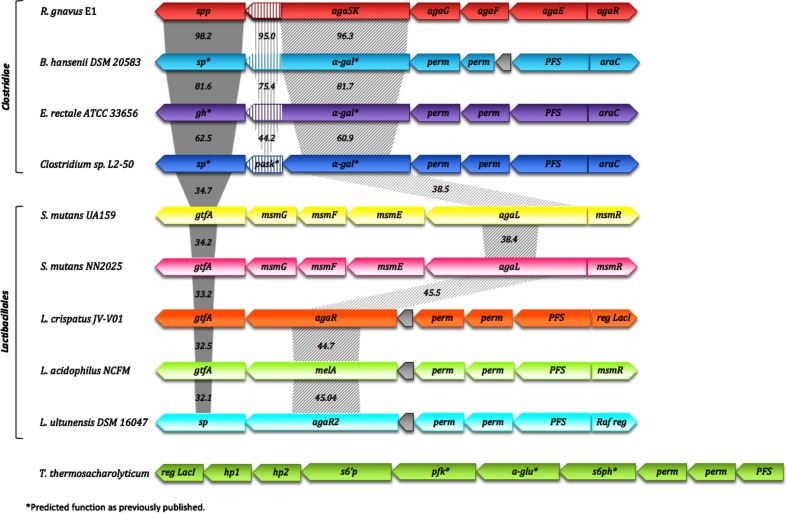
Genomic environment of the Rgspp gene. The values indicate the percentage identities between spp or sp, kinase and α-gal genes.